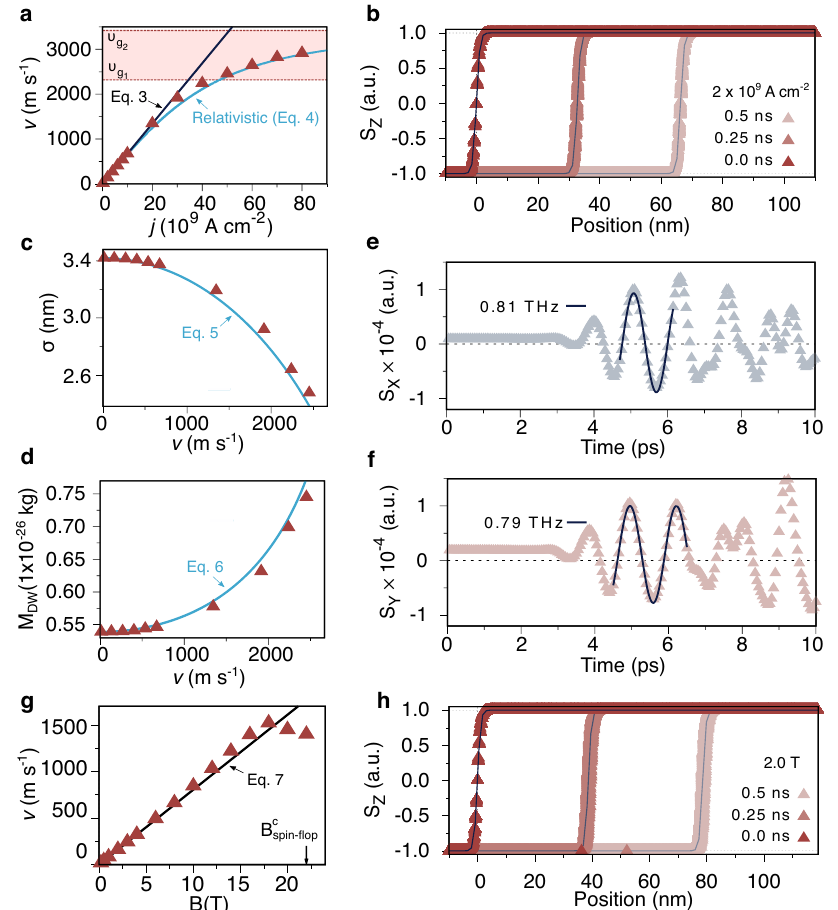
Fig. 3 Relativistic effects on domain wall motion. a Simulated domain wall velocity v (m s − 1 ) versus current density j (10 9 A cm − 2 ) (triangles) considering two fi ts to the data. In the low-velocity regime, Eq. (3) is used to describe the linear dependence (black curve). In the relativistic regime, Eq. (4) provides an accurate description over the entire range of densities. Maximum group velocities v g 1 and v g 2 are shown for comparison via horizontal dashed lines in the colored region. b Variation of the out-of-plane component of the magnetization S z across the domain wall with a current density of 2 × 10 9 A cm − 2 at t = 0.0, 0.25, 0.5 ns. The calculated points are fi tted to Eq. (2) shown with the solid line. The variation in position of the center of the domain wall as a function of time is used to extract the wall velocity which is an average over all atoms at the domain wall. c , d Current-driven domain wall width σ (nm) and domain wall mass M DW , respectively, versus v . Fits to Eqs. (5) and (6) are included for comparison. e, f In-plane components of the magnetization S x , y (a.u.) versus time (ps), respectively, for j = 2 × 10 9 A cm − 2 . Frequencies within the range of 0.79 − 0.81 THz can be extracted from S x , y shown via the solid curves in a full circle. g , Domain wall velocity versus magnetic fi eld applied perpendicular to the surface. The dashed line is given by y = 86.28 x with linear regression coef fi cient R 2 = is highlighted. h Similar as b but at an applied fi eld of 2.0 T. The initial condition shows 0.9996. The critical fi eld for spin- fl op transition B c spin (cid:2) flop that the spin directions of all atoms at the same x (and any y ) appear superimposed on top of each other, revealing a highly ordered system. As the wall motion starts, atoms at the same x but different y no longer have the same spin direction, leading to a continuous distribution of